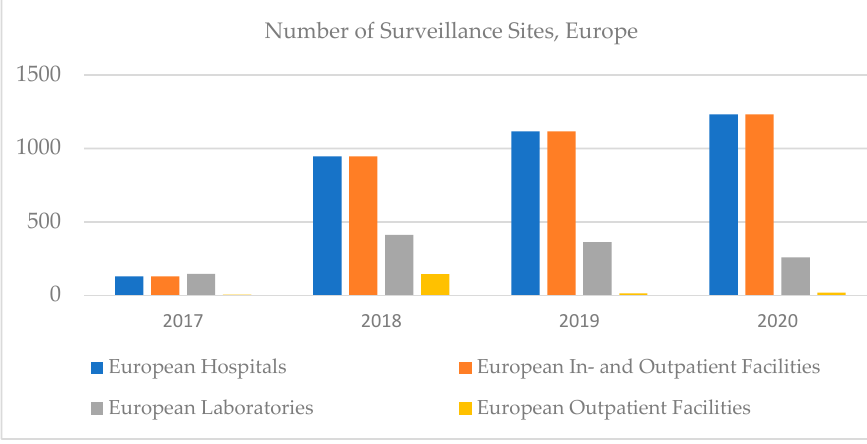
Figure 7. Number of surveillance sites, Europe, 2017–2020. In South-East Africa, the number of hospitals and in- and outpatient facilities in- creased, outpatient facilities being registered in 2020, and clinical laboratories increased until 2019, then decreased (Figure 8).